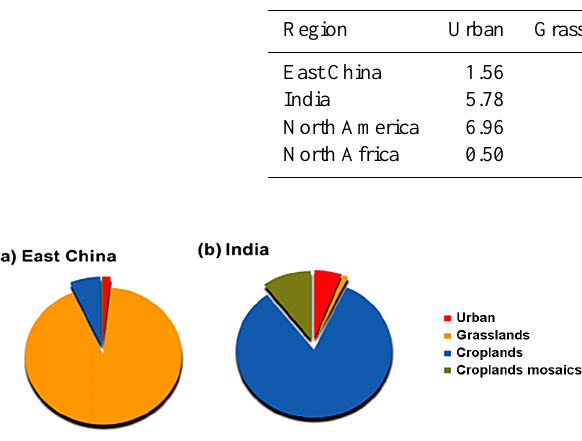
Table 4. Different land cover area percentage (%).